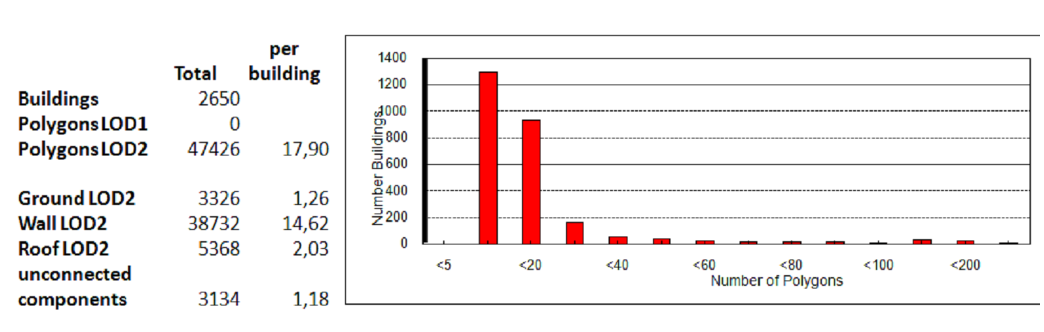
Figure 5: The test data set contains 2650 buildings (LoD2 geometry) with 47426 polygons in total. The diagram shows the distribution of polygons per building